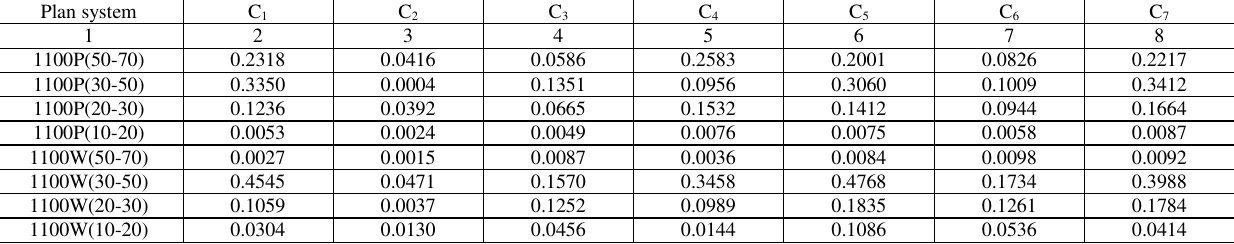
Table 1. Numerical values of the diagnostic variables for HC